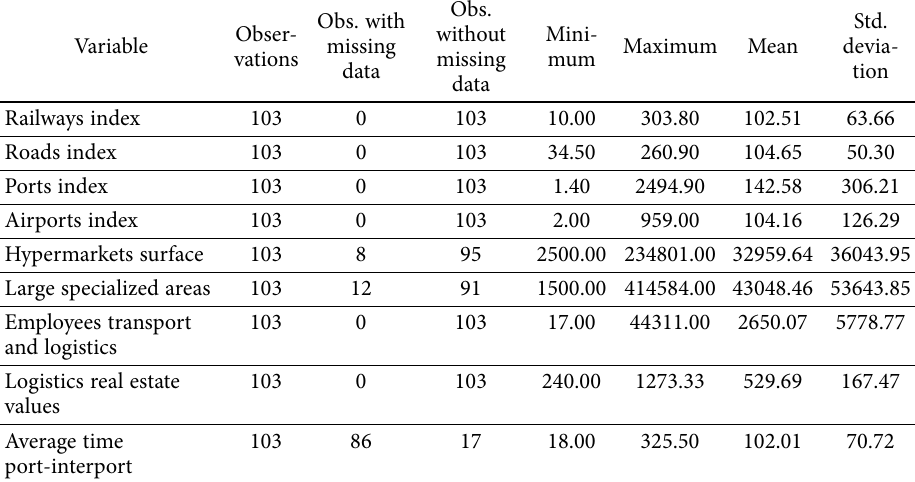
Table 2. Summary statistics NUTS3 level data